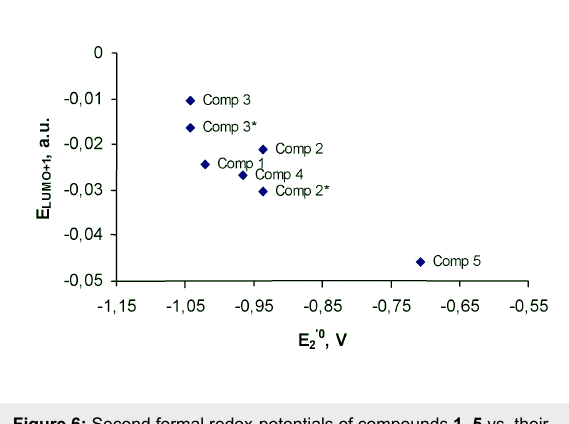
Figure 4: First formal redox-potentials of compounds 1 – 5 vs. their calculated LUMO energies.